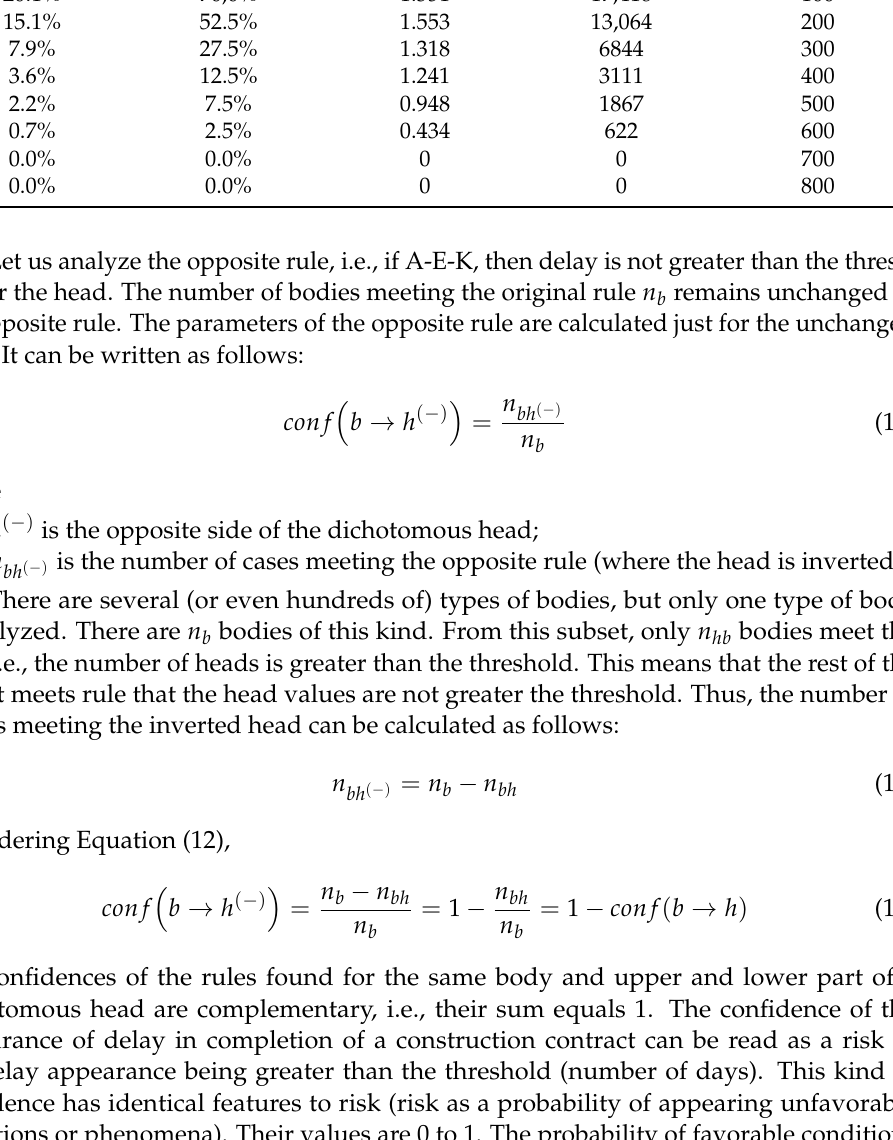
Table 8. Parameters of the rule with Cr-E-J-L body calculated for several thresholds of delay. Support (%) Confidence (%) Lift Score D